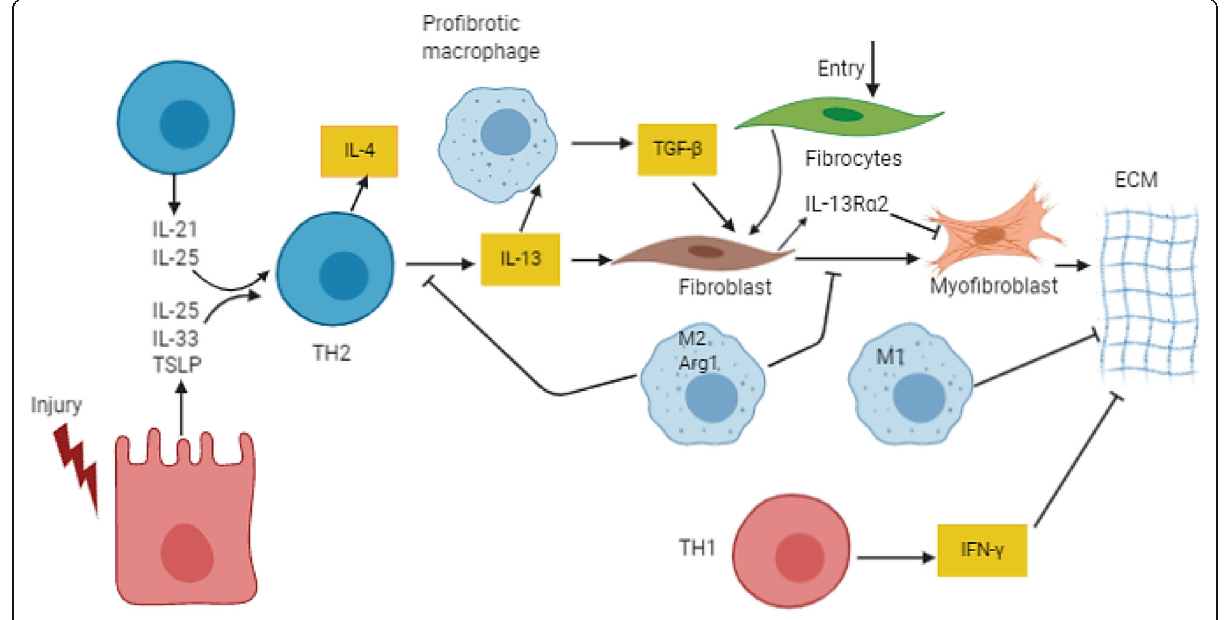
Fig. 3 ECM formation by activation of macrophages and T helper cells